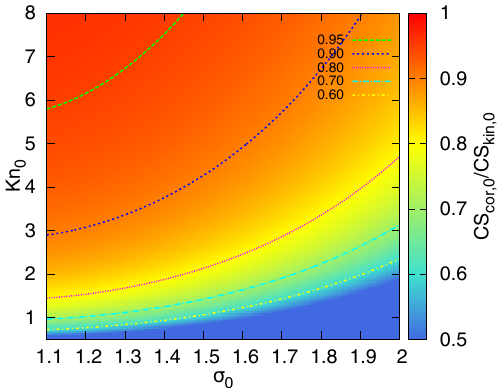
Figure 3. The ratio CS cor , 0 / CS kin , 0 as a function of σ 0 (character- izing the width of the particle number distribution) and the Knudsen number Kn 0 (corresponding to the geometric mean diameter of the